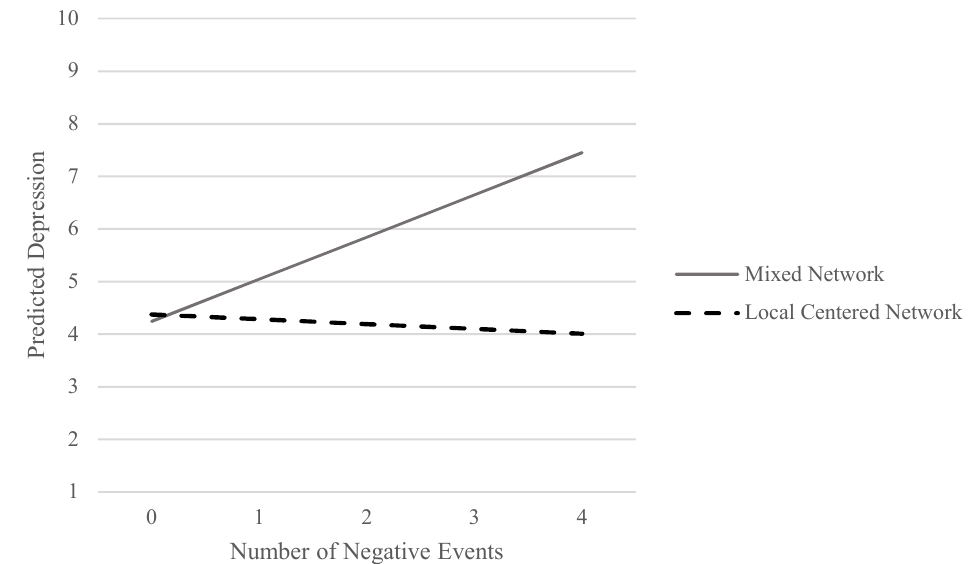
Figure 7. Difference between Mixed Network and Local Centered Network in buffering the adverse impact of negative life events on depression.